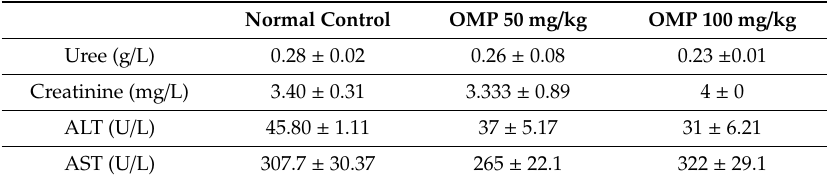
Table 2 indicates the effect of the OMP on relative organ weight. According to the results, there Table 1. E ff ect of subacute administration of OMP on biochemical parameters in male mice ( n = 5). Normal Table 2. Effect of subacute administration of OMP on the relative weight of organs.